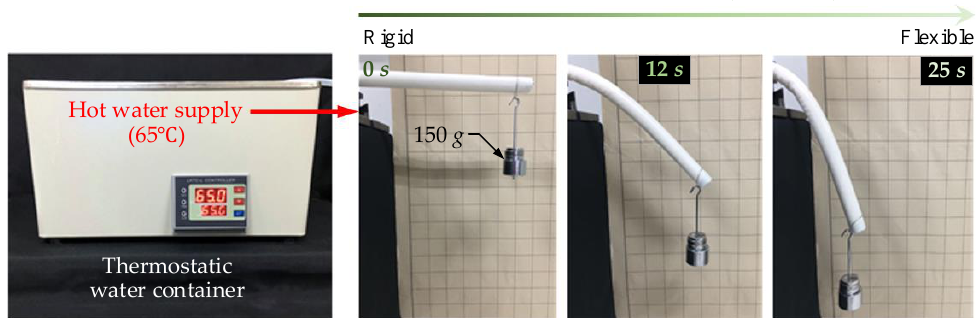
Figure 5. Flexible mode activation (from rigid mode to flexible mode) time test with constant hot water (65 ◦ C) supply, shapes of manipulator at 0 s, 12 s and 25 s were